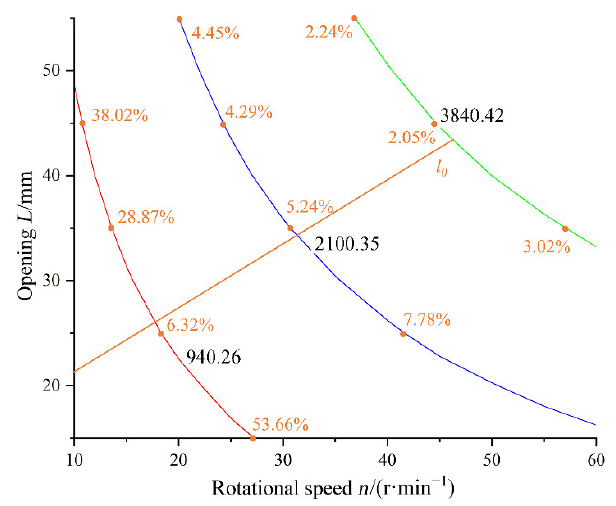
Figure 9. Distribution of fertilizer discharge CV under different control sequences.